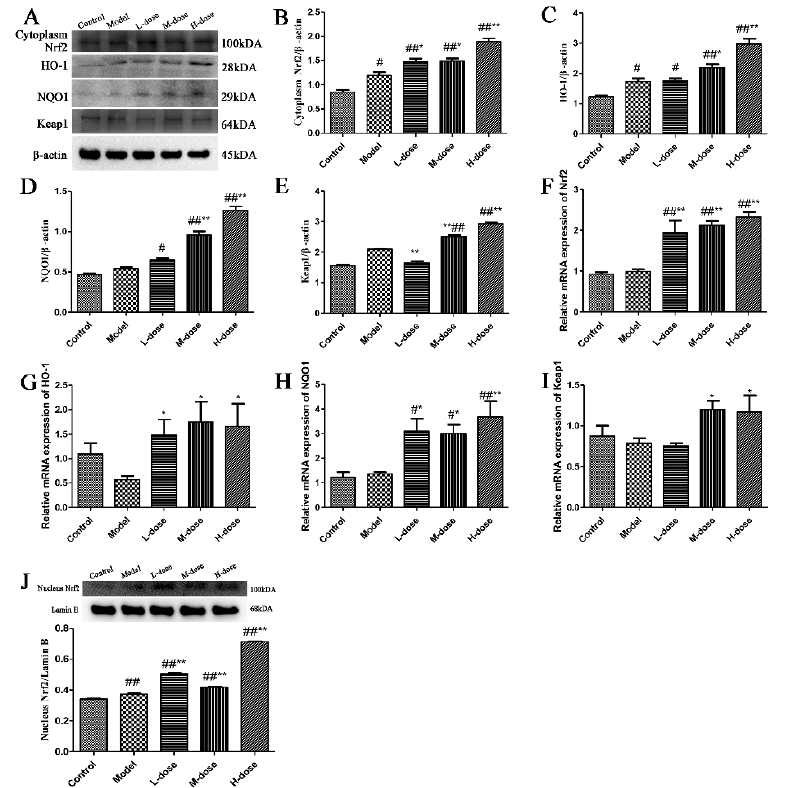
Figure 3. Forsythia suspensa extract enhances the antioxidant activity in mouse colon tissue. ( A – E ) Western blot analysis of cytoplasm for Nrf2, HO-1, NQO1 and Keap1. ( F – I ) qRT–PCR detection of Nrf2 , HO-1 , NQO1 and Keap1 gene expression levels. ( J ) Western blot analysis of the level of nuclear Nrf2. The results are shown as the mean ± SEM. # p < 0.05, and ## p < 0.01 compared with the control group; * p < 0.05, and ** p < 0.01 compared with the model group; #** means # and **; ##** means ## and